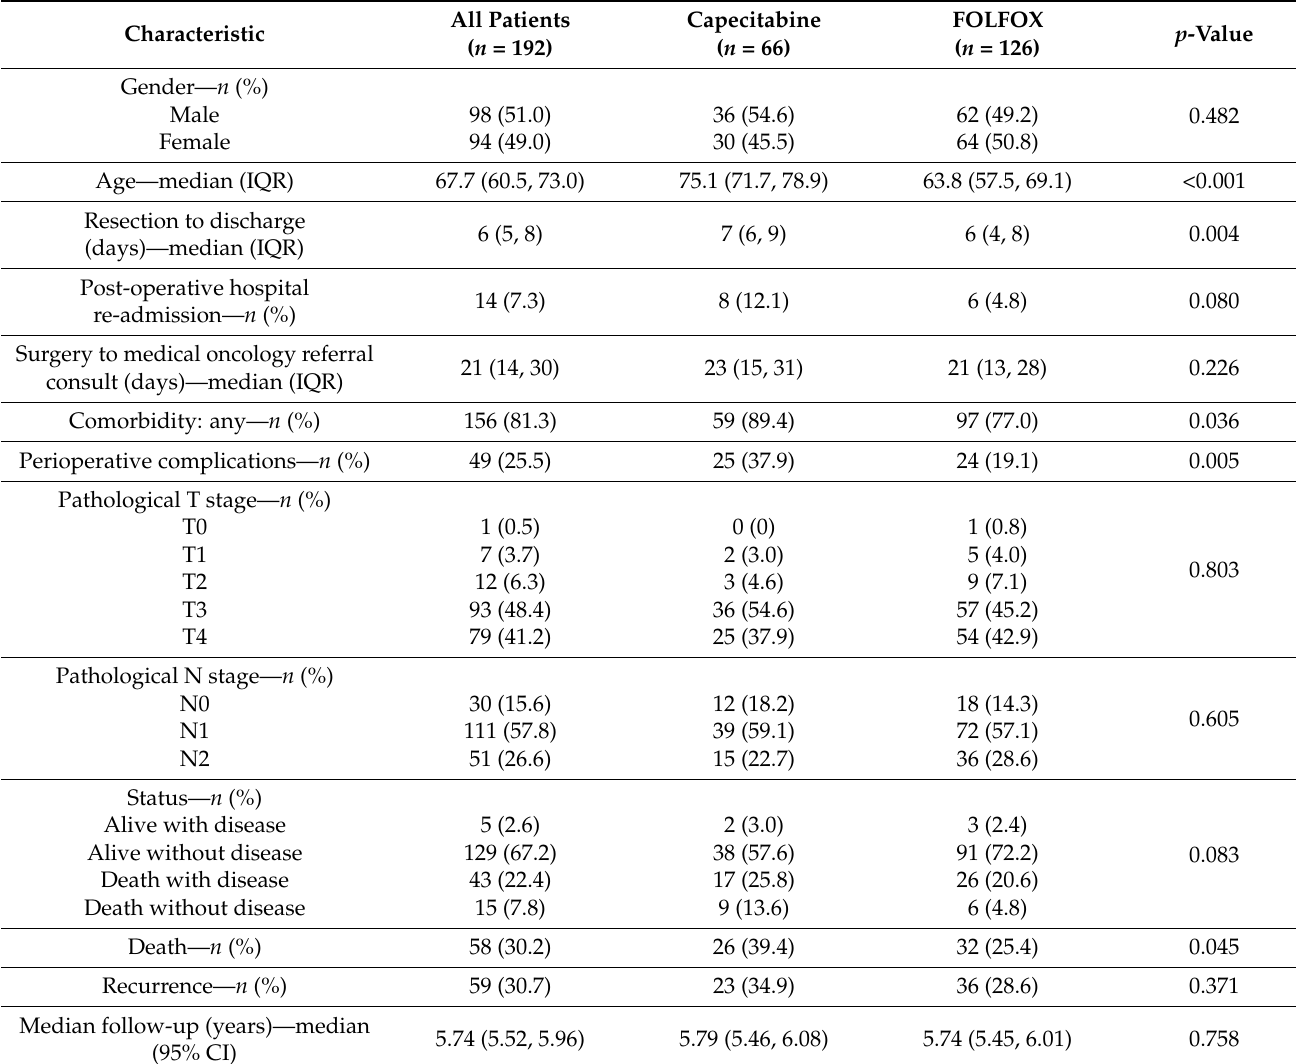
Table 1. Baseline patient characteristics ( n =